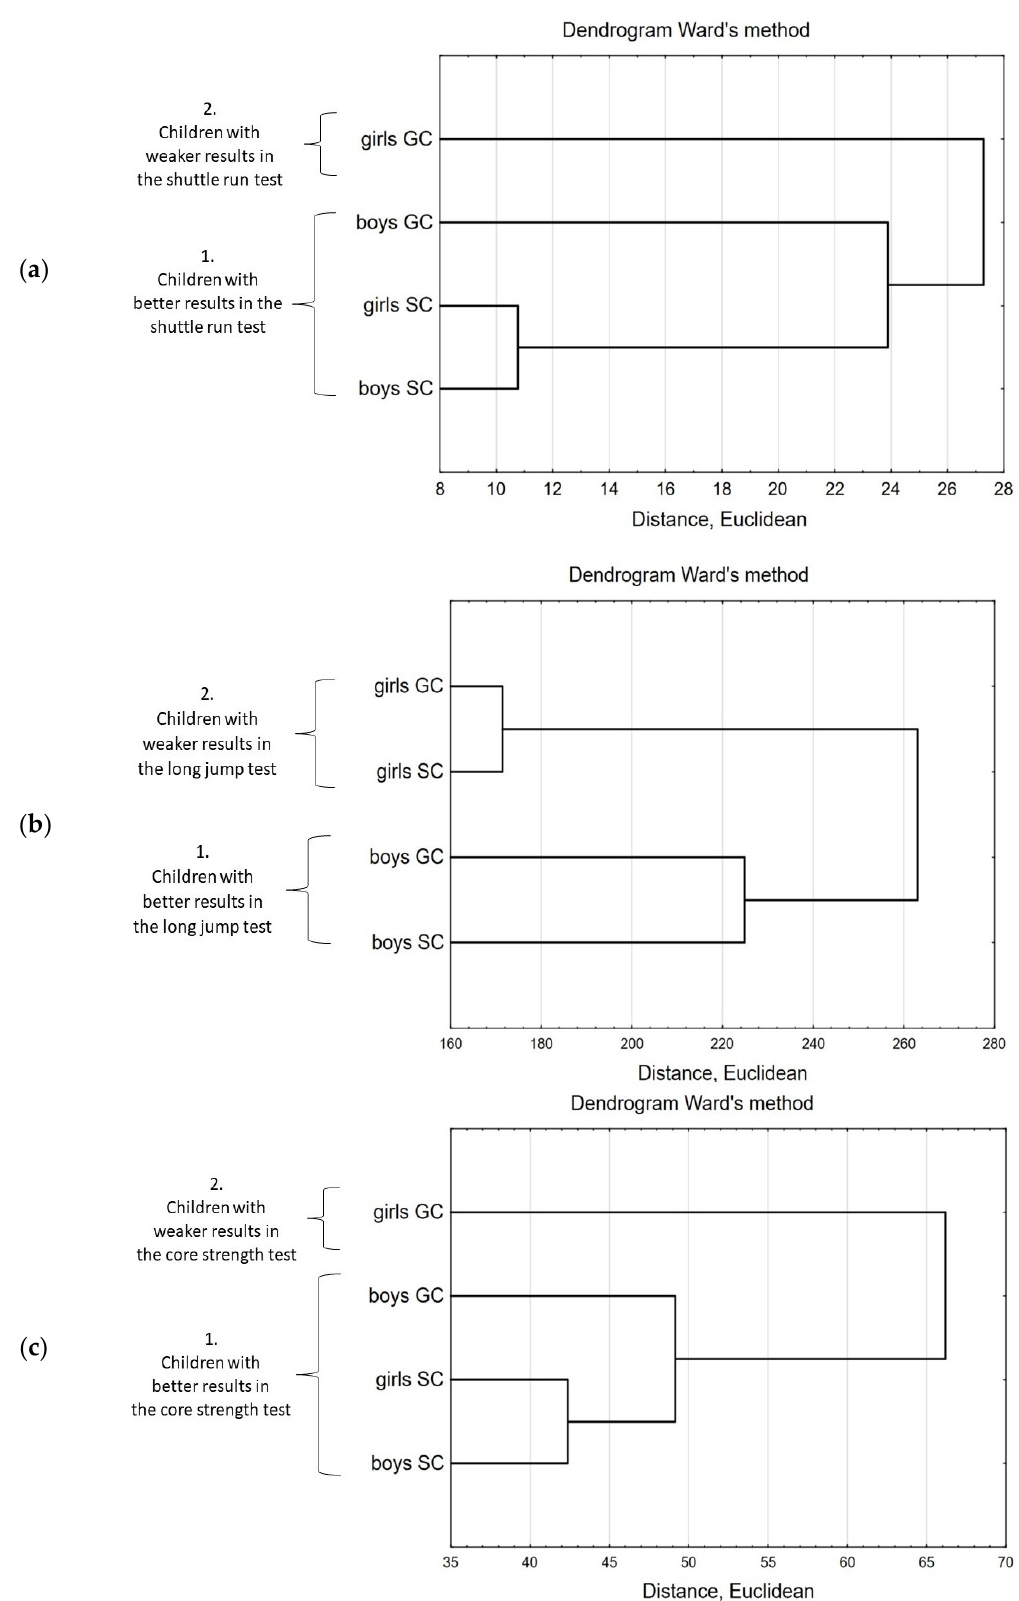
Figure 4. The cluster analysis of SC and GC boys and girls fitness tests results; separated clusters showed groups of similar results in particular tests: ( a ) shuttle run test; ( b ) long jump test; ( c ) core strength test. GC—general education classes; SC—sport classes.